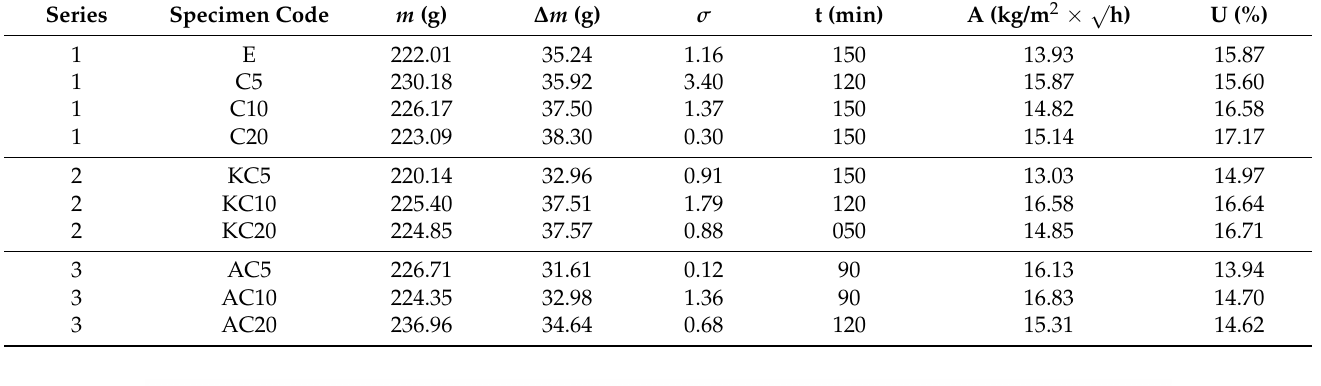
Table 3. Capillary water absorption: mass of the specimens ( m ), mass of the absorbed water ( ∆ m ), and its corresponding standard deviation ( σ ).